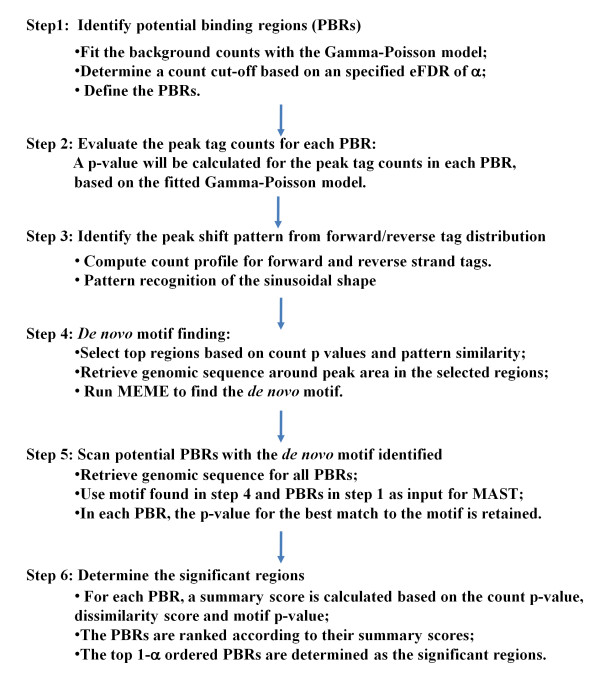
Sequence the ChIP-PaM algorithm.